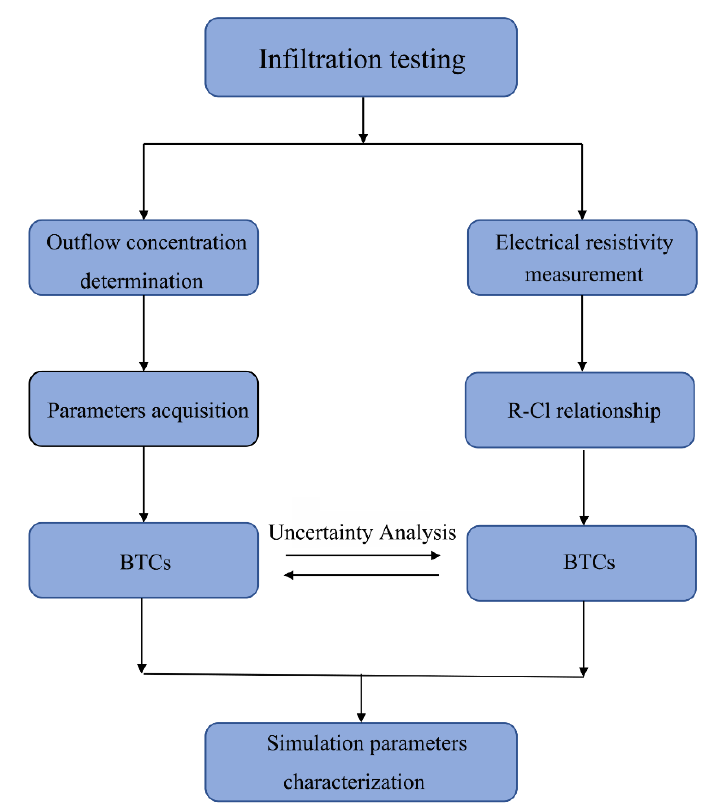
Figure 2. Research flow for determining BTCs using ERT.